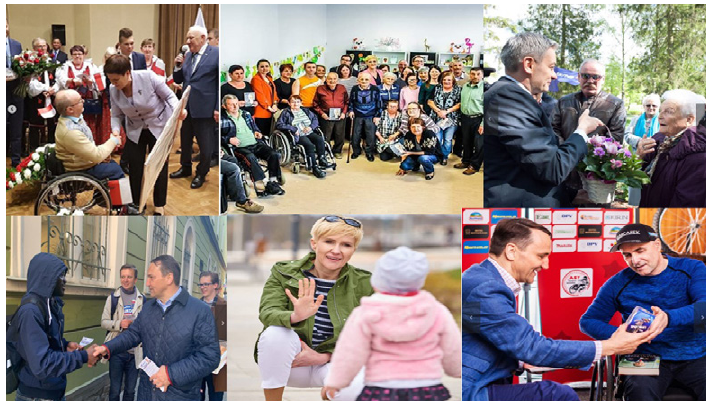
Figure 3. Photos of candidates among “the vulnerable” ( topos of the protector) (source: Instagram